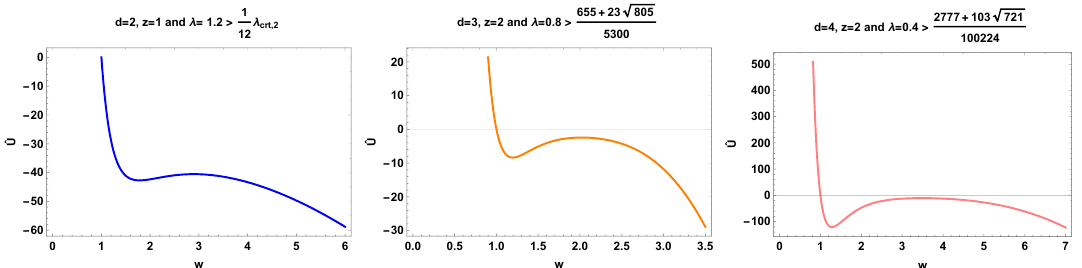
ˆ Figure 7 . The effective potential U ( w ) as a function of w for θ = 0 and different values of d , z and λ . For the values of λ given in table 3 there is a maximum w fB outside the horizon.